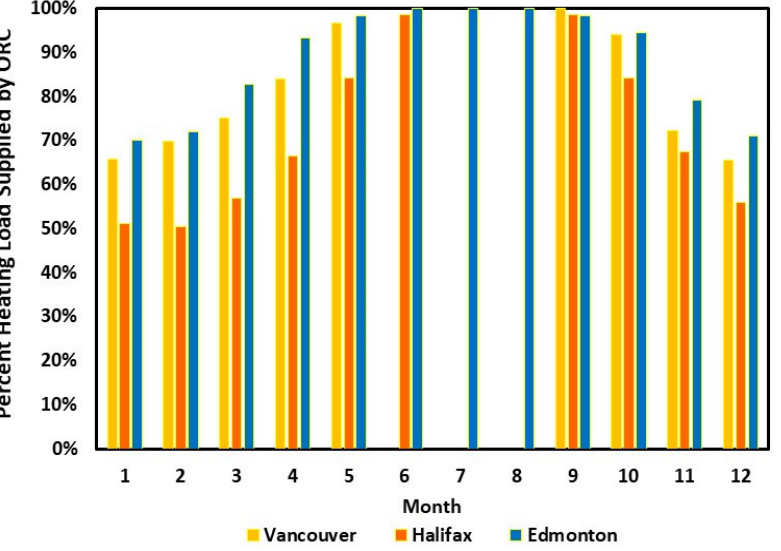
Figure 9. Percent of total heating load supplied by the ORC during the first year in each